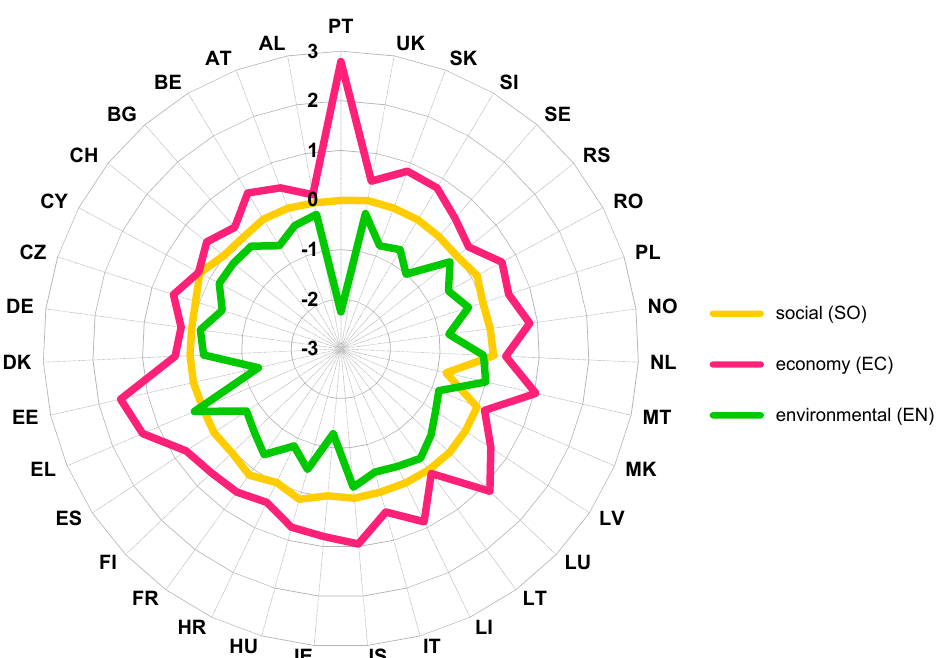
Figure 4. Sustainability assessment of local change directions in small towns and suburbs.